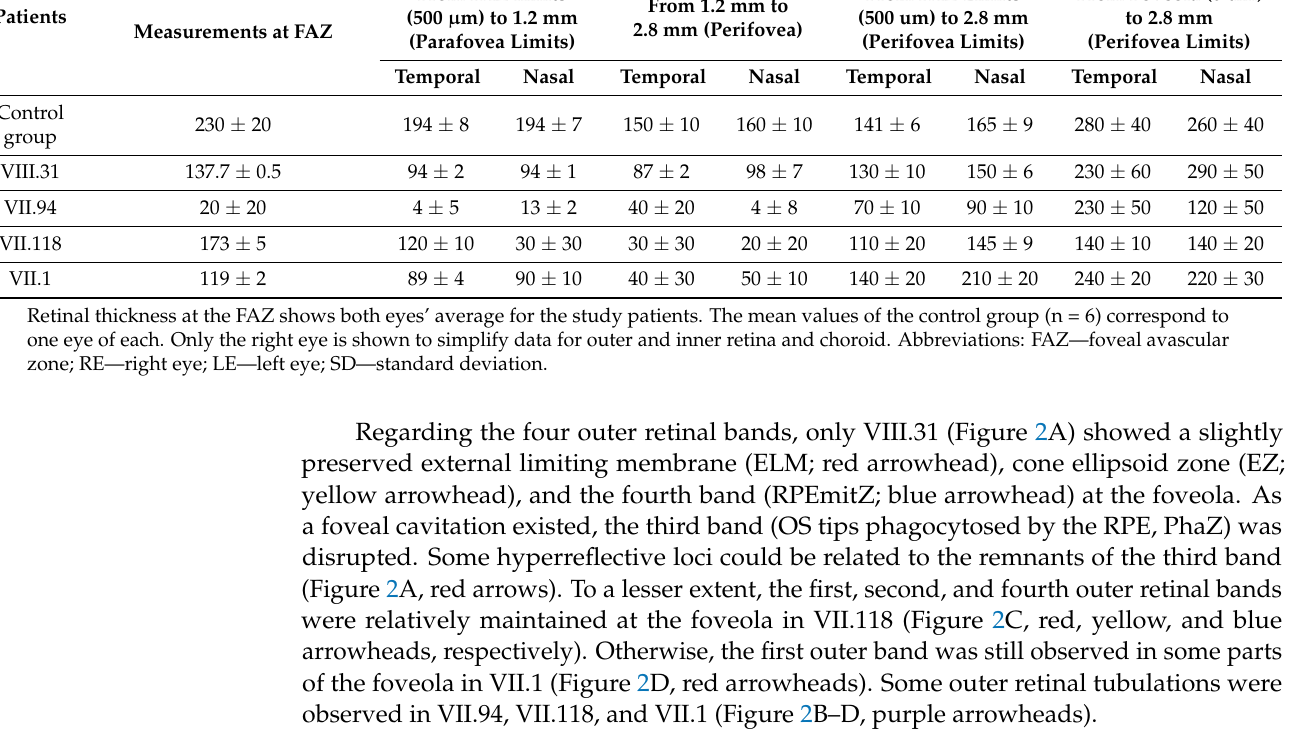
Table 2. Thickness in total, outer, and inner retina, and choroid in optical coherence tomography (OCT).